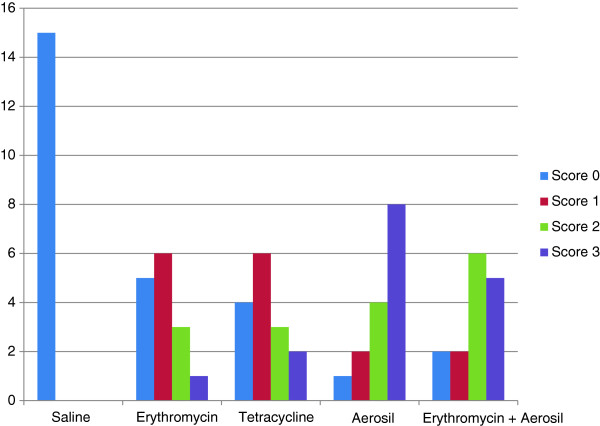
Frequency of macroscopic scores in the treatment groups. Microscopic scores were 0 = normal pleura, 1 = multifocal fibrosis, 2 = diffuse adhesions and 3 = complete obliteration.